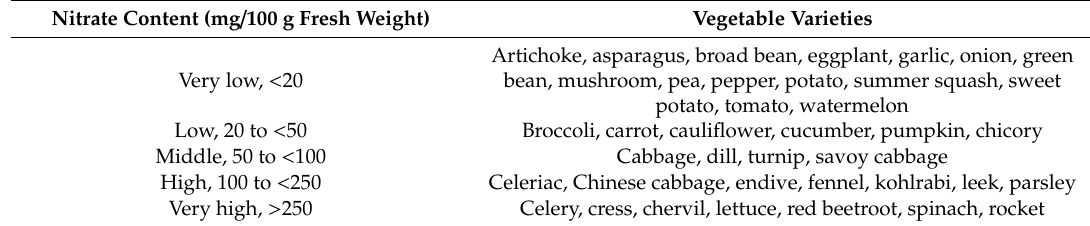
Table 1. Classification of vegetables according to nitrate content *.